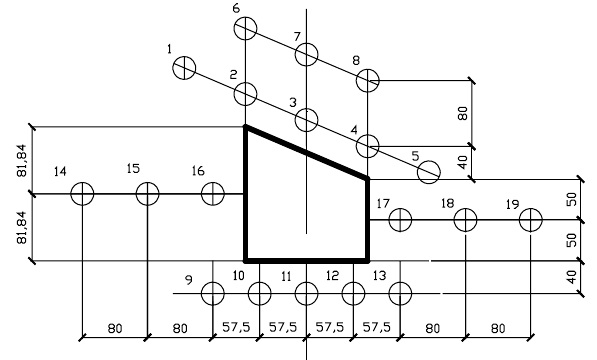
Figure 4. Layout of stress measuring points of roadway surrounding rock (mm).